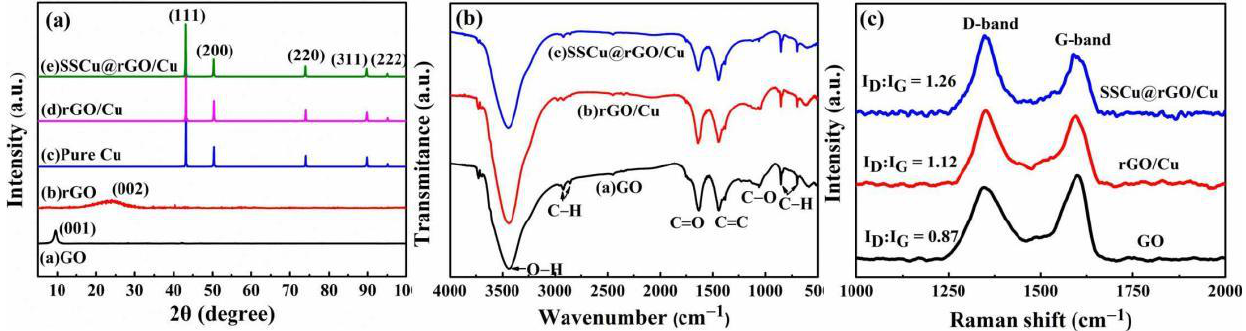
Figure 2. Phase analysis of GO, rGO, the rGO/Cu composites, and the SSCu@rGO/Cu composites: ( a ) XRD spectra, ( b ) FT-IR spectra, and ( c ) Raman spectra.